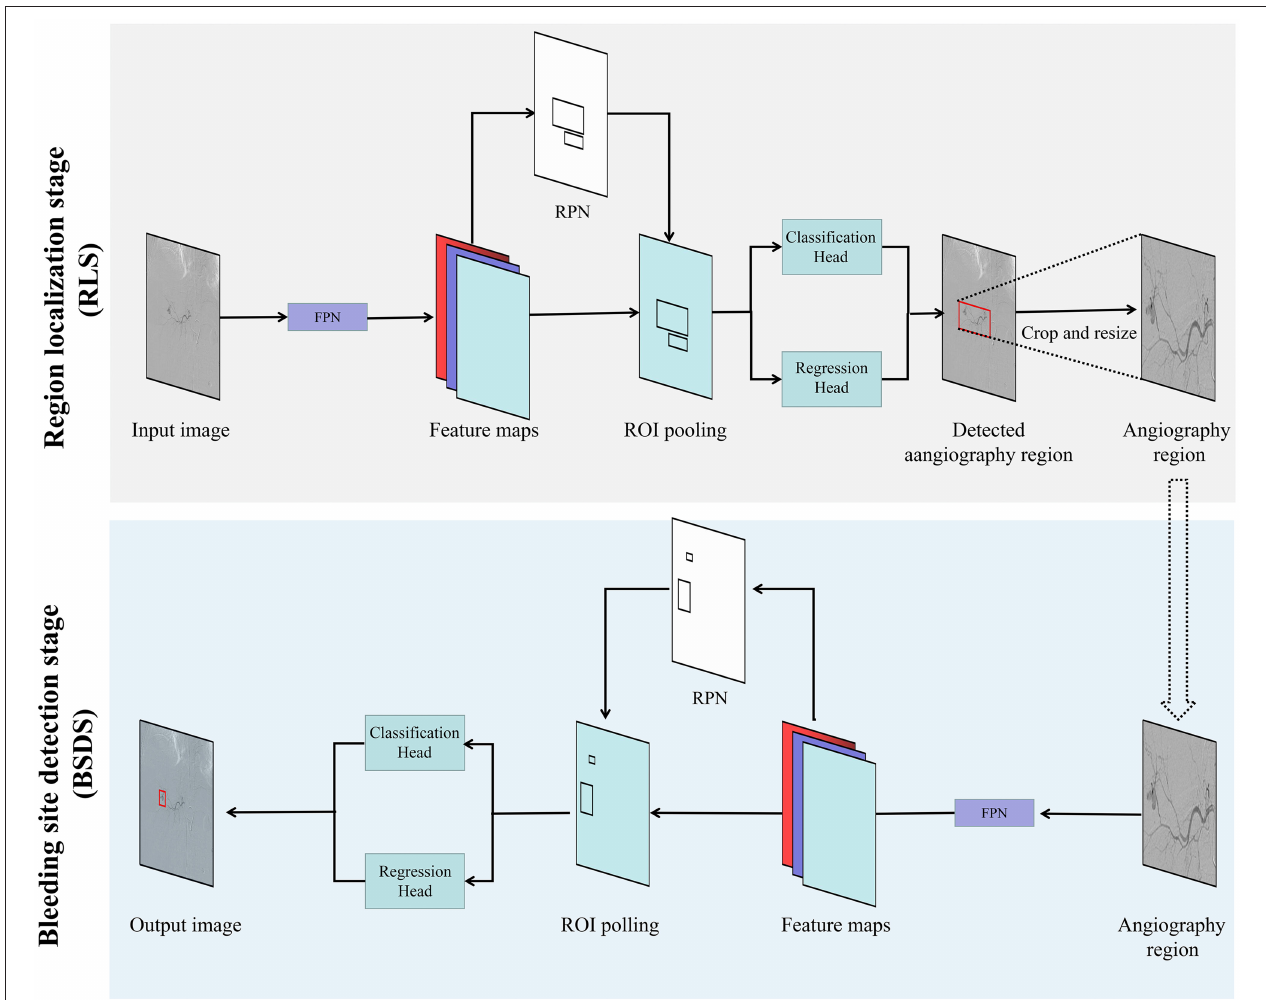
FIGURE 1 | Overview diagram of the proposed two-stage deep learning approach (InterNet). The system first detected the angiographic region from the original frame image. The output of the RLS was used as input in the next stage of redundancy reduction. RPN, region proposal network; ROI, region of interest; FC, fully connected layer; Bbox, bounding